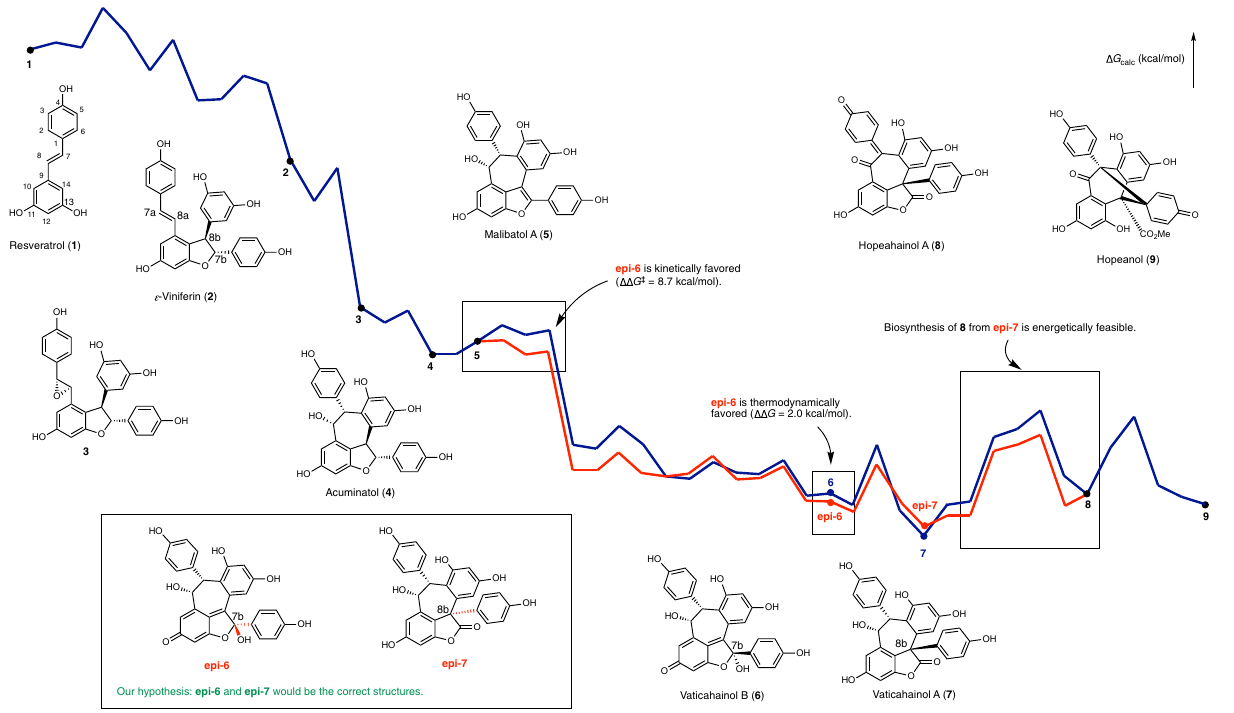
Fig. 1 Summary of the results obtained from DFT calculations. Energy diagram of the biosynthetic route of resveratrol dimers and the predicted correct structures of vaticahainol B and